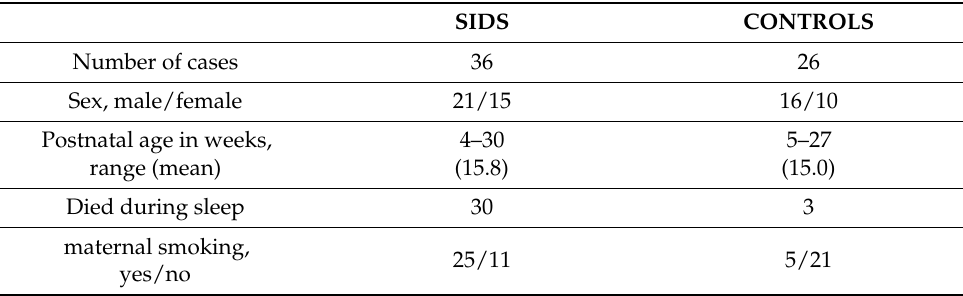
Table 1. Demographic Data of the Individuals Included in this